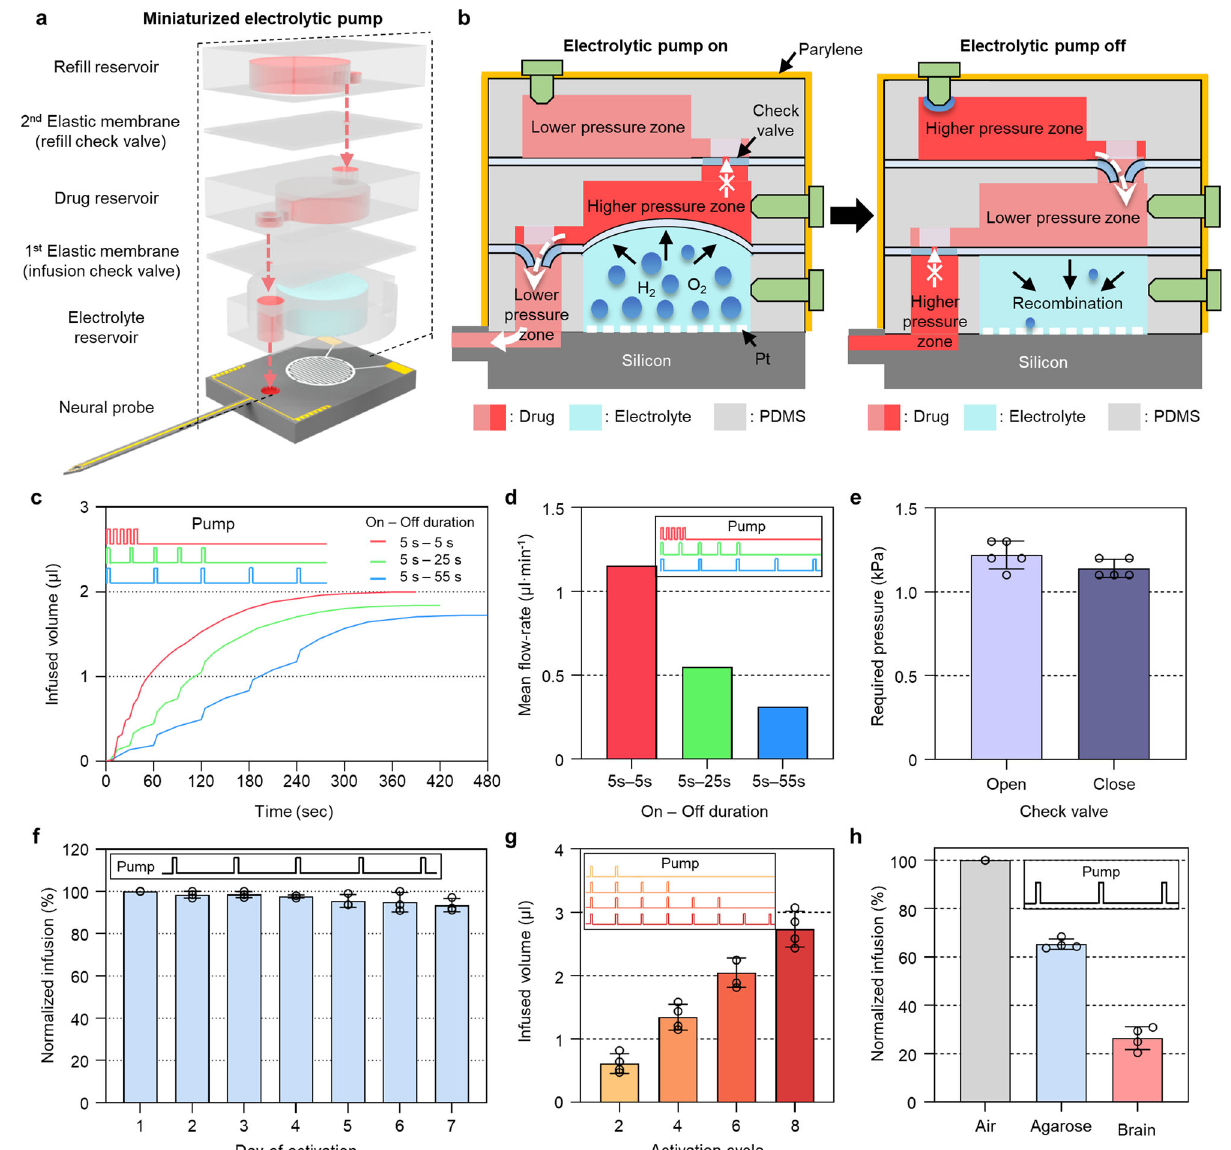
Fig.2|Characterizationoftheminiaturizedelectrolyticpump.a Explodedview ofaminiaturizedelectrolyticpump,consistingofthreereservoirlayers,twoelastic membranes with inherently formed check valves, and a drug deliverable neural probe with the interdigitated electrode (IDE). b Series of schematic illustrations showing sequential on-off operations of the electrolytic pump. c Infused volume overtimebyactivating5cycleswith10s(5sonand5soff),30s(5sonand25soff), and60s(5sonand55soff)period.Thesketchinsetinthegraphshowstheonand offtimesofthepumpoverawholeperiod. d Mean fl